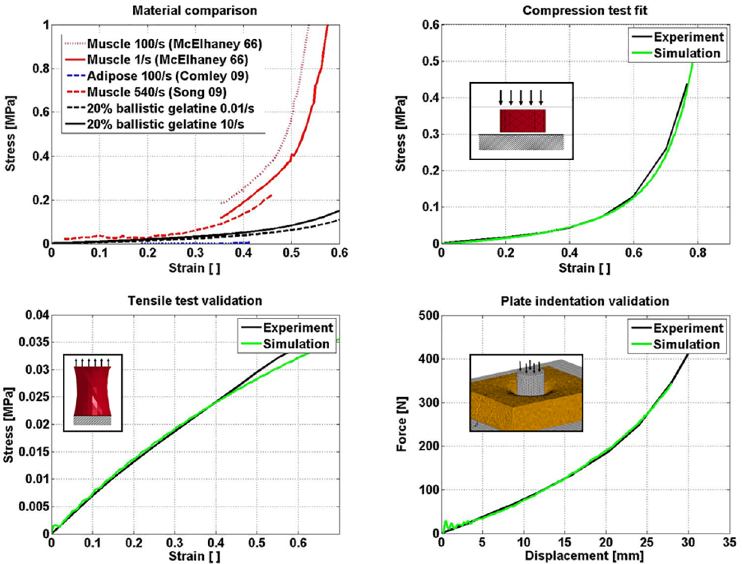
Fig 3. Top left: Comparison of ballistic gel, muscle [33, 34] and adipose tissue [32] response in compression. Top right: compression test results at a strain rate of 10/s compared to simulation. Bottom left: tensile test results at a strain rate of 10/s compared to simulation. Bottom right: plate indentation test results for indentation speed of 50 mm/s compared to simulation. The plate thickness was 51.6 mm.